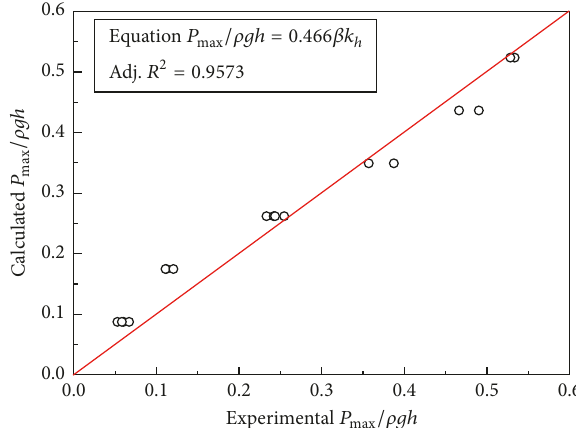
Figure 13: A comparison of the calculated values obtained from a linear fit of the experimental hydrodynamic pressure data at P3 for